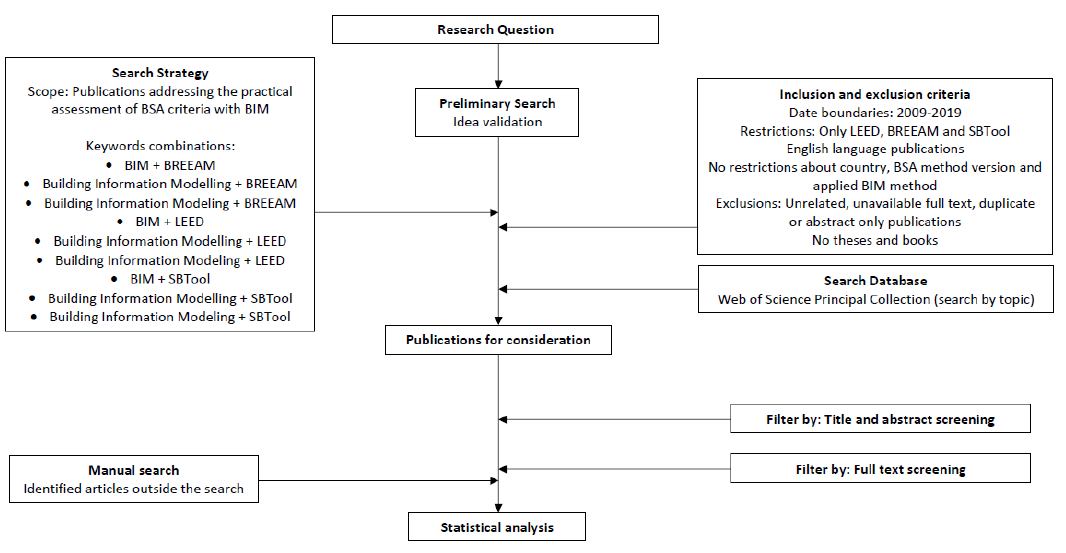
Figure 1. Systematic review procedure.